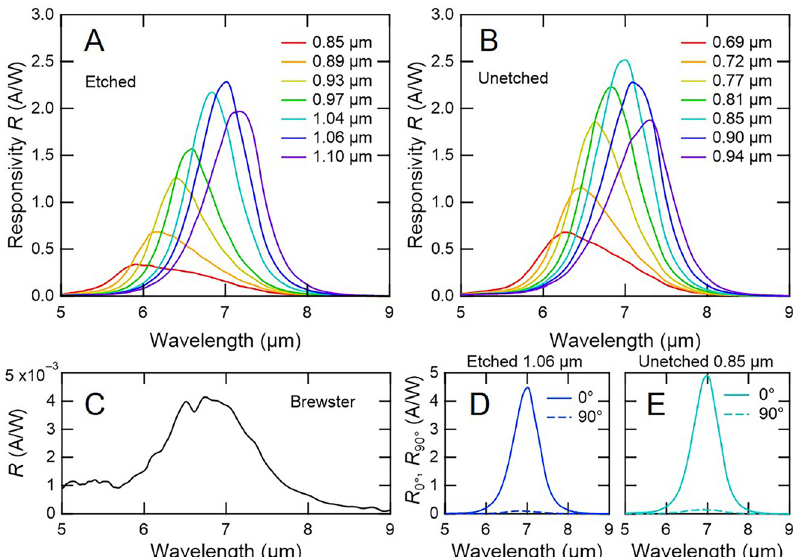
Figure 3: Experimental unpolarized responsivity spectra for A) etched and